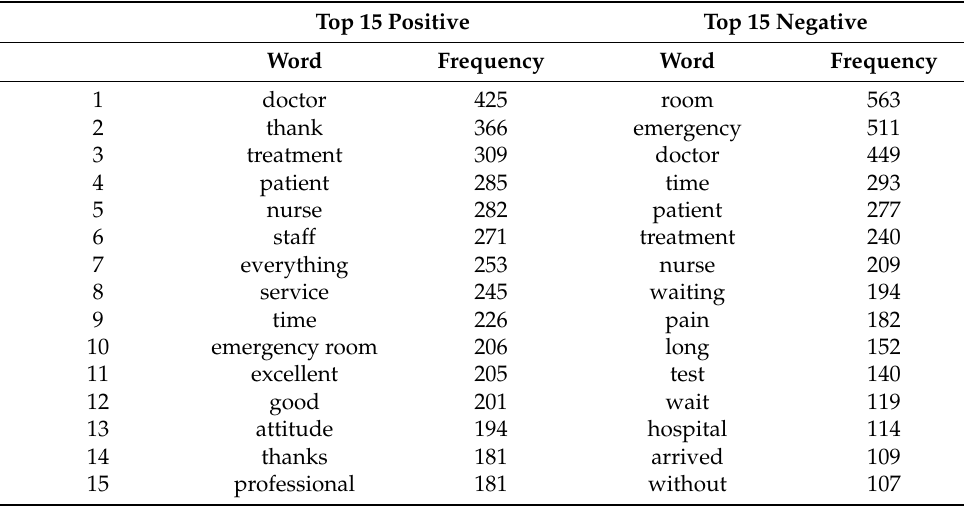
Table 6. Frequencies of top 15 words used in positive and negative